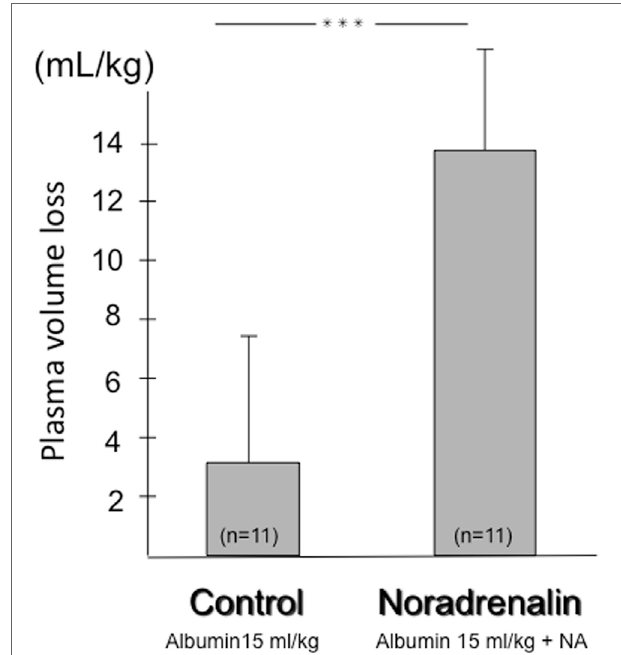
FiGURe 8 | Effects on plasma volume in the septic rat of a bolus infusion of 5% albumin of 15 mL/kg, measured 2.5 h after the infusion in a control group with baseline mean arterial blood pressure and in a group where mean arterial blood pressure was increased by 12 mmHg using noradrenalin infusion. The loss of plasma volume was significantly greater in the noradrenalin group (14 mL/kg as opposed to 3 mL/kg), with loss of the main part of the infused volume. Data from Ref. (89), with permission.